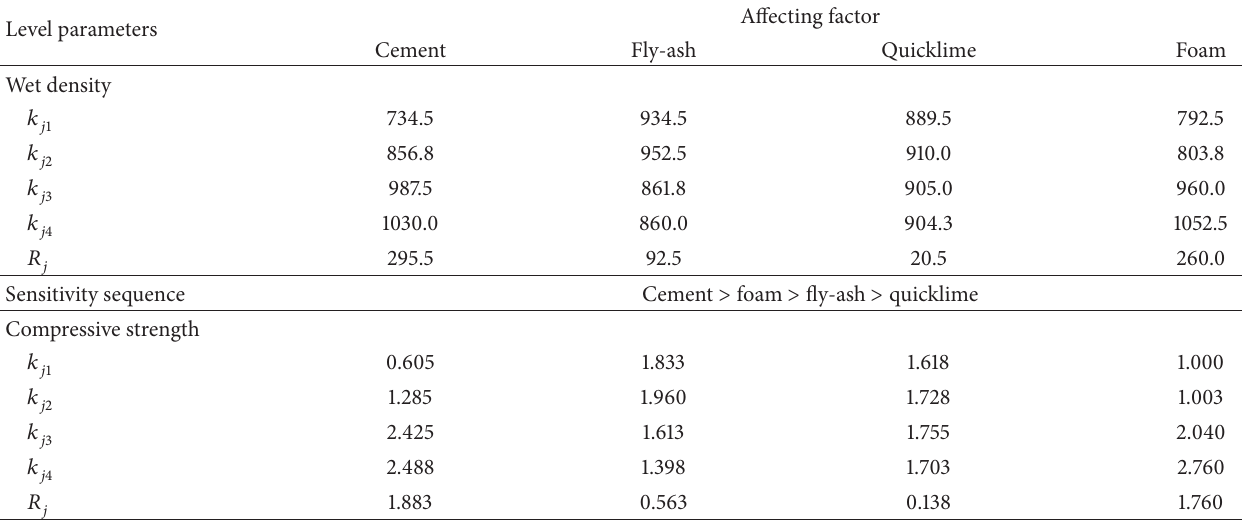
Table 5: The range analysis